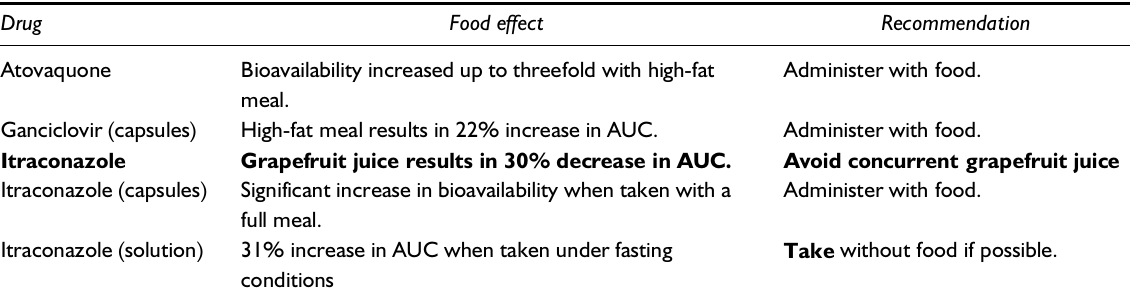
Table 4 Effects of Food on Drugs used to prevent opportunistic